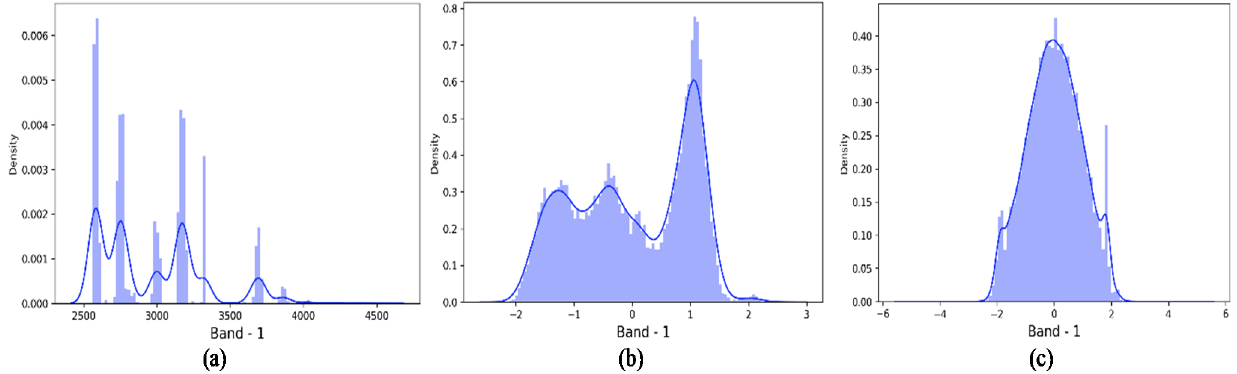
Figure 3. The three shapes of the data distribution, ( a ) is the original data, ( b ) is the change of data distribution after using principal components analysis (PCA), and ( c ) is the data distribution after using quantile transformation principal components analysis (QPCA).